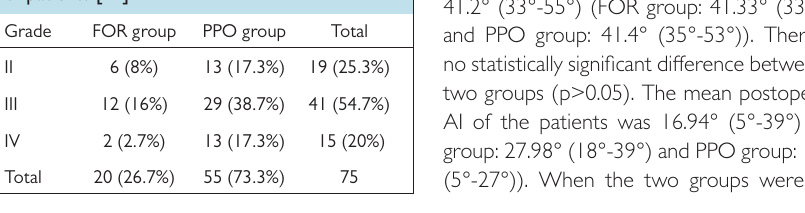
expected value (<3). In comparison with cate- gorical variables >2×2, Pearson’s chi-square test